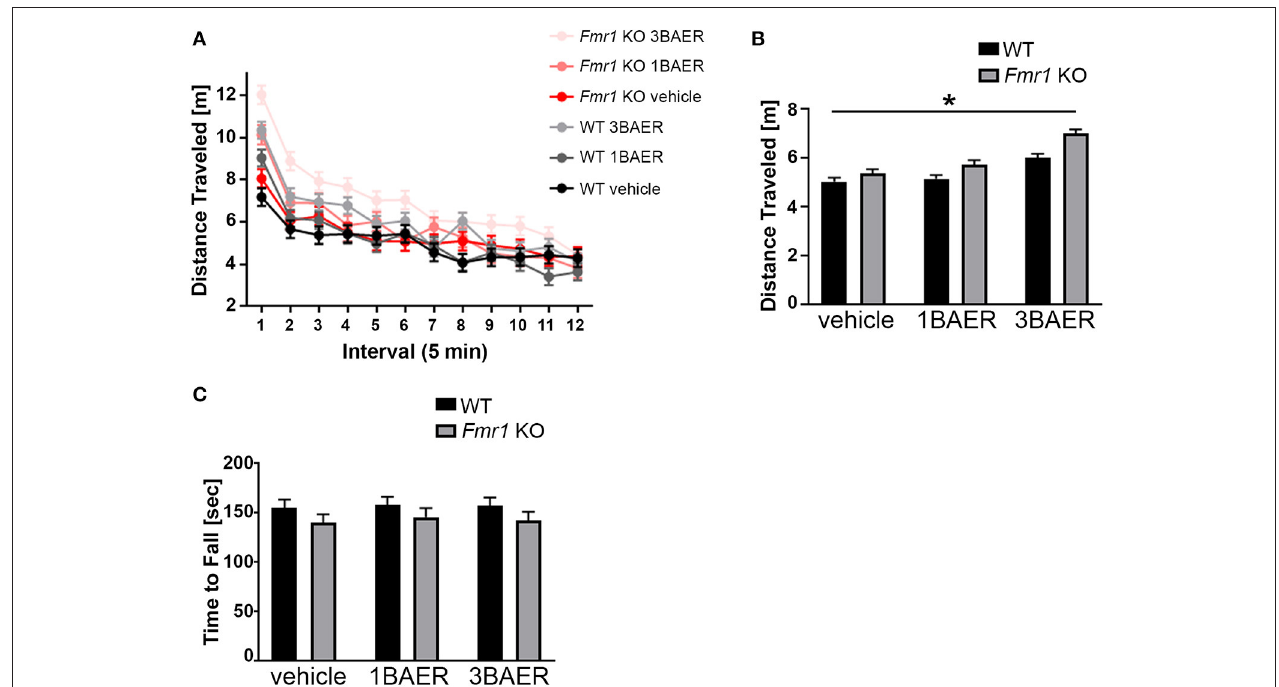
FIGURE 4 | BAER-101 increases motor activity regardless of genotype but does not affect motor coordination. (A,B) Distance traveled in an open field is overall increased in Fmr1 KO mice compared with WT littermates and further increased by BAER-101 treatment [ A , 3-way ANOVA, p (genotype) < 0.0001, p (treatment) < 0.0001, p (interval) < 0.0001, p (treatment x interval) < 0.0001, p (treatment x genotype) = 0.16, p (treatment x interval x genotype) = 0.79]. FDR-corrected pairwise comparisons of data collapsed over time show significant differences for WT vehicle compared with Fmr1 KO 3 mg/kg BAER-101 ( B , * p = 0.0015). (C) Fmr1 KO mice fell off the rotarod faster than their WT littermates but both genotypes improved over time. No effect of low- or high-dose BAER-101 treatment was detected [3-way ANOVA, p (genotype) = 0.044, p (treatment) = 0.87, p (day) < 0.0001, p (genotype x treatment) = 0.98, p (genotype x day) = 0.70, p (treatment x day) = 0.33, p (genotype x treatment x day) = 0.71]. Figure in (C) shows data collapsed over 2 days. WT vehicle: n = 23, WT 1BAER: n = 25, WT 3BAER: n = 24, Fmr1 KO vehicle: n = 21, Fmr1 KO 1BAER: n = 20, Fmr1 KO 3BAER: n =